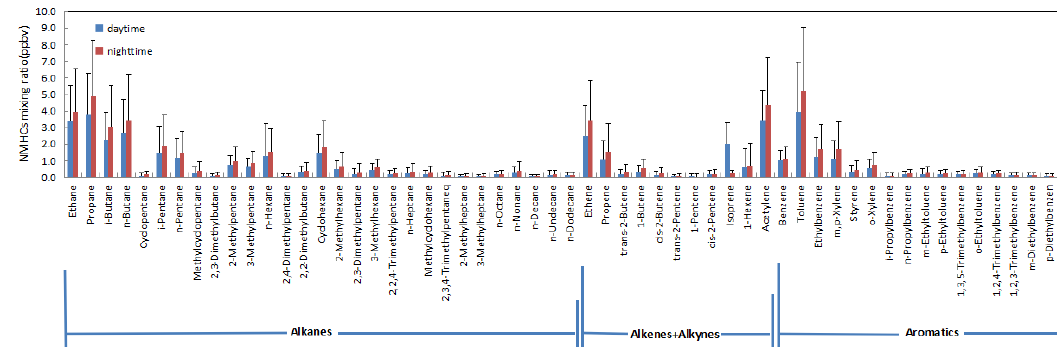
Figure 2. Average day- (7:00–18:00 LT) and night-time (19:00–6:00 LT) average mixing ratios of 56 NMHCs at GPACS (unit: ppbv). Error bars represent standard deviations from June 2011 to May 2012. Table 3. Isoprene ambient mixing ratios measured at different locations in temperate and subtropical zones.